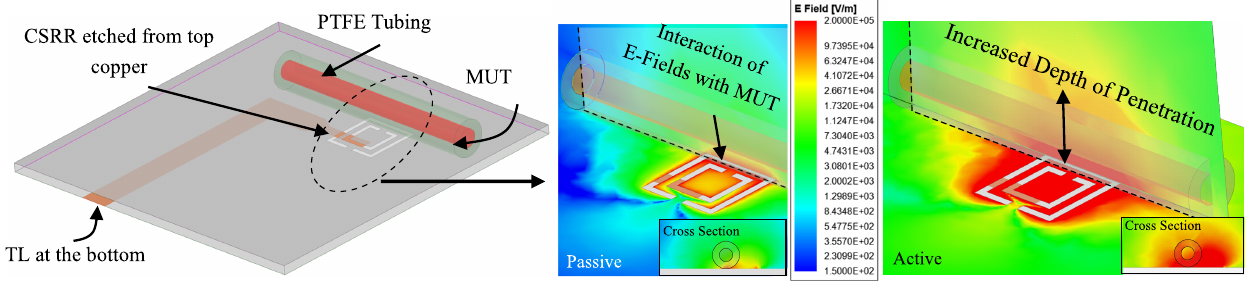
Figure 5. Simulation setup in HFSS with | E | field demonstration on the surface of the CSRR as well as the cross-section of MUTs above